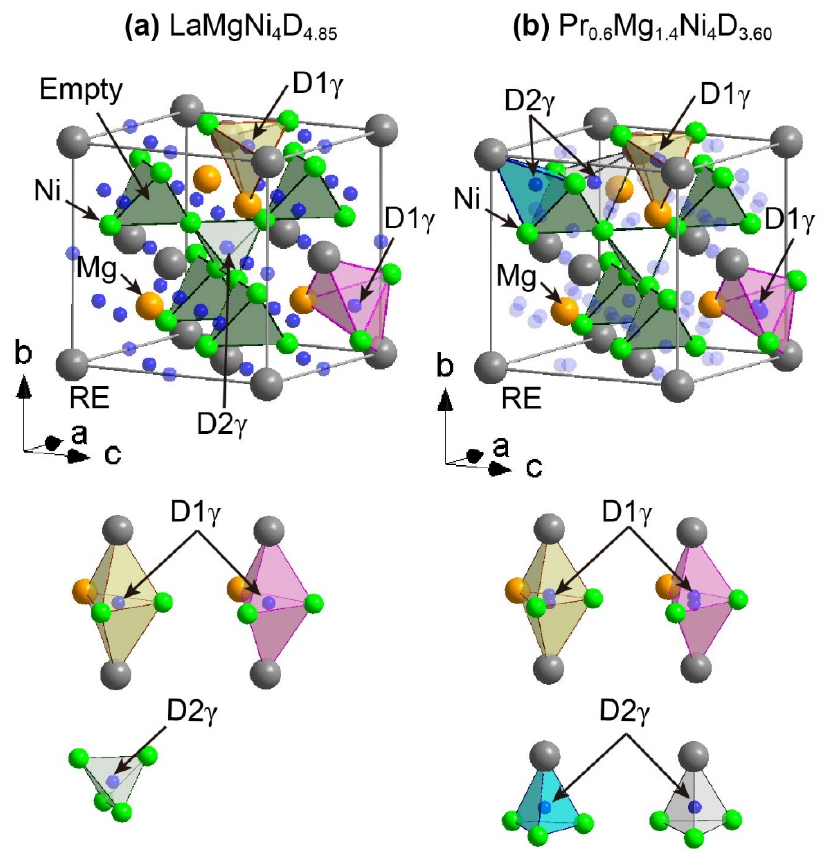
Figure 5. Crystal structures of γ hydride phases based on ( a ) LaMgNi 4 D 4.85 [24] and ( b ) Pr 0.6 Mg 1.4 Ni 4 D 3.60 . [28]. The La (Pr), Mg, and Ni D atoms are represented by grey, orange, and green spheres, respectively. Parts of Pr atoms are replaced by Mg atoms in Pr 0.6 Mg 1.4 Ni 4 D 3.60 . The corner-shared tetrahedra formed by four Ni atoms are represented as the green polyhedra. The original orthorhombic unit cell is represented as white line. In the local atomic arrangements around the D atoms, the hydrogen sites (D1 γ ) in the triangular bipyramid are represented as yellow and pink polyhedra. In the local atomic arrangements around the D atoms, the hydrogen sites (D2 γ ) in the tetrahedra are represented as green (LaMgNi 4 D 4.85 ), cyan (Pr 0.6 Mg 1.4 Ni 4 D 3.60 ), and grey (Pr 0.6 Mg 1.4 Ni 4 D 3.60 ) polyhedra.